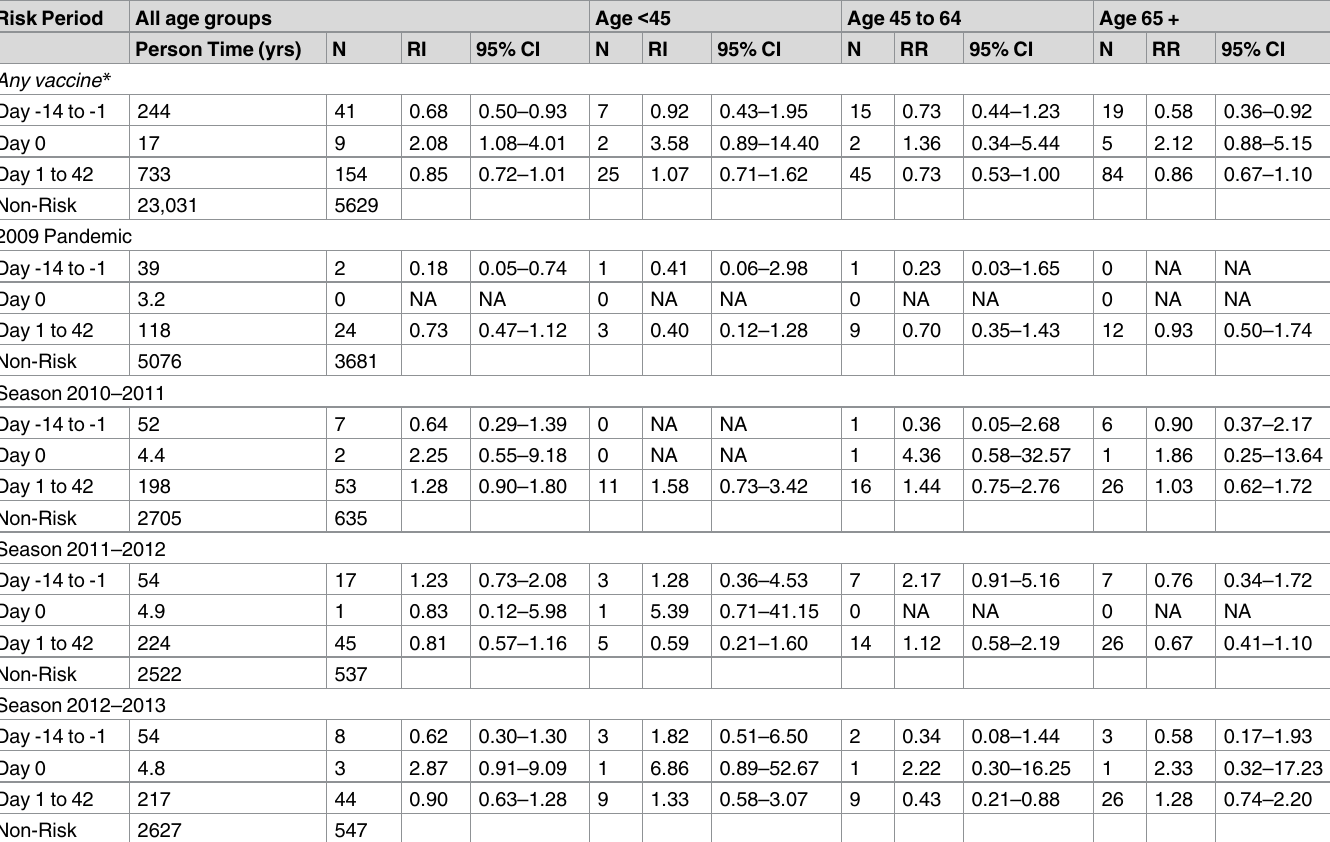
Table 3. Age and season specific relative incidences (95% CI) of Bell’s palsy within 42 days of influenza vaccination (adjusted for seasonality, ARI consultations and